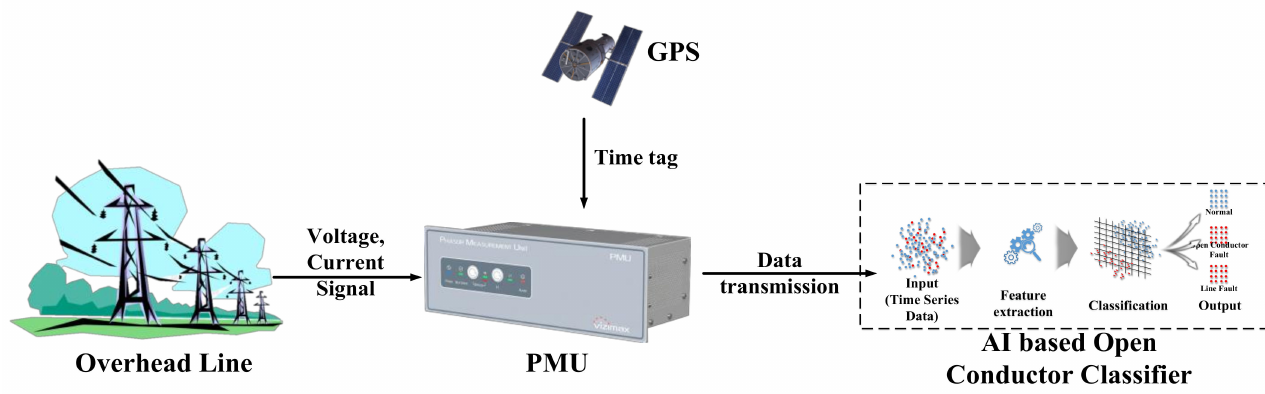
Figure 3. Conceptual diagram of the proposed